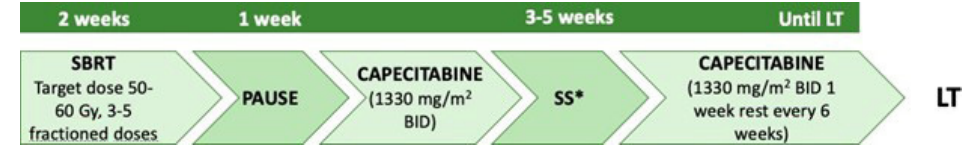
Figure 5. University of Michigan neoadjuvant protocol. SBRT: stereotactic body radiotherapy; SS: staging surgery; LT: liver transplant; BID: twice a day. * with lymph nodes biopsies.